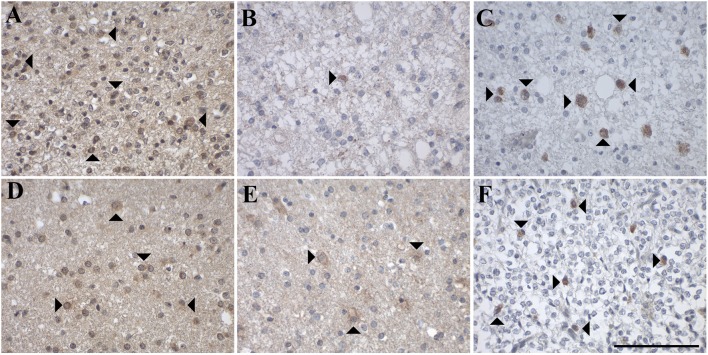
Representative images of immunohistochemical stainings of oligodendroglial tumors with (A–C) oligodendroglioma (WHO grade II; case 37, 52, 52) and (D–F) anaplastic oligodendroglioma (WHO grade III; case 44, 44, 57). GAL immunoreactivity is shown in (A,D); GAL1-R immunoreactivity in (B,E), and GAL3-R immunoreactivity in (C,F). Arrow heads indicate positive-stained cells. [scale bar: 100 μm].